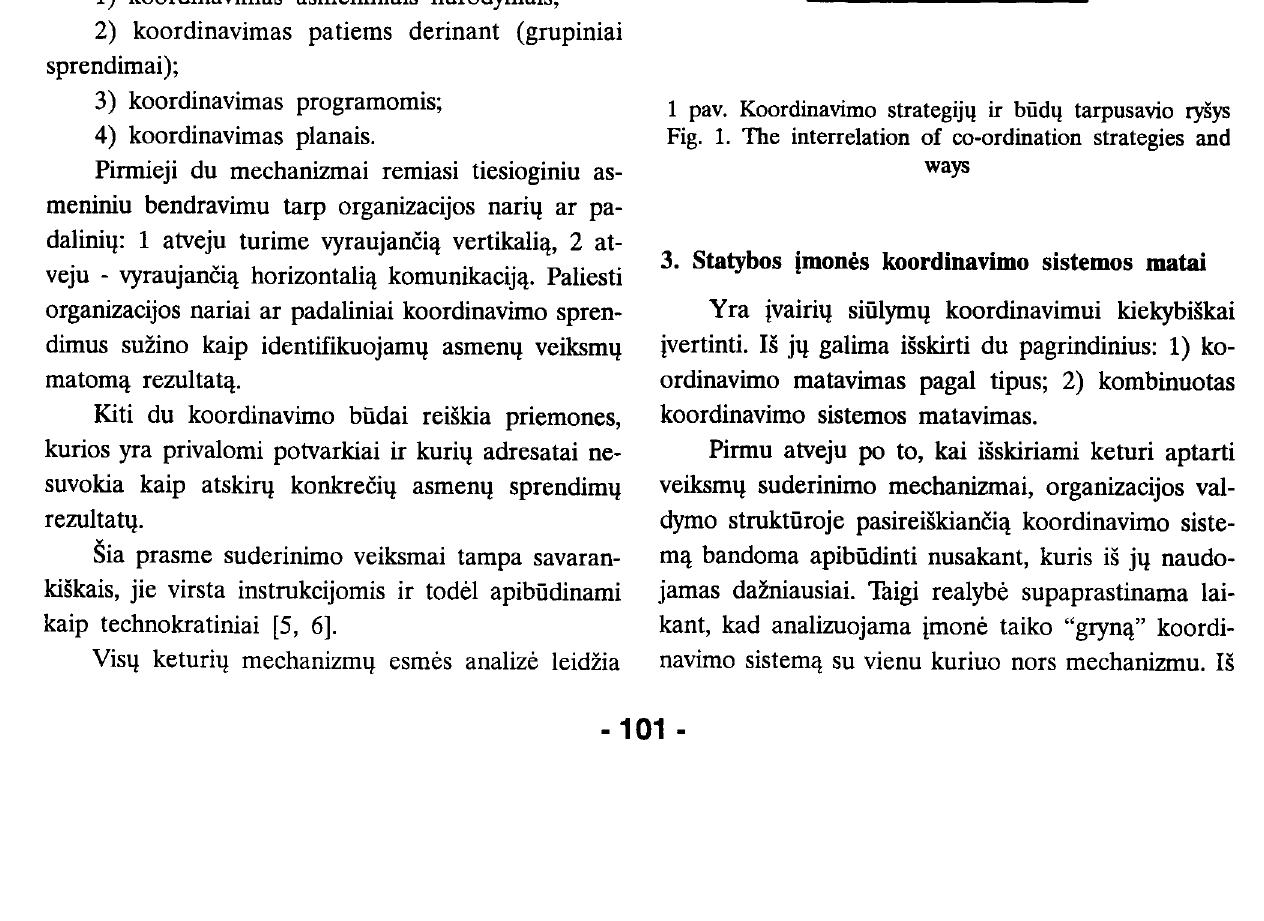
Fig. 1. The interrelation of co-ordination strategies and